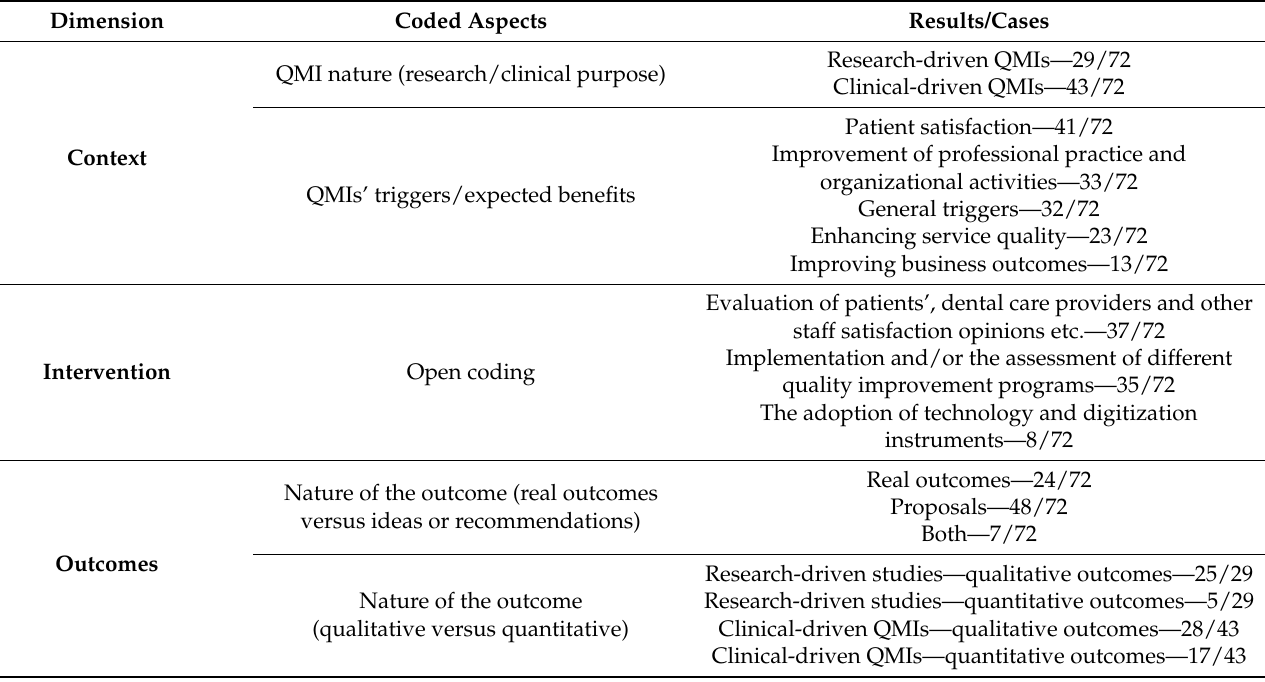
Table 2. Context, intervention and outcomes